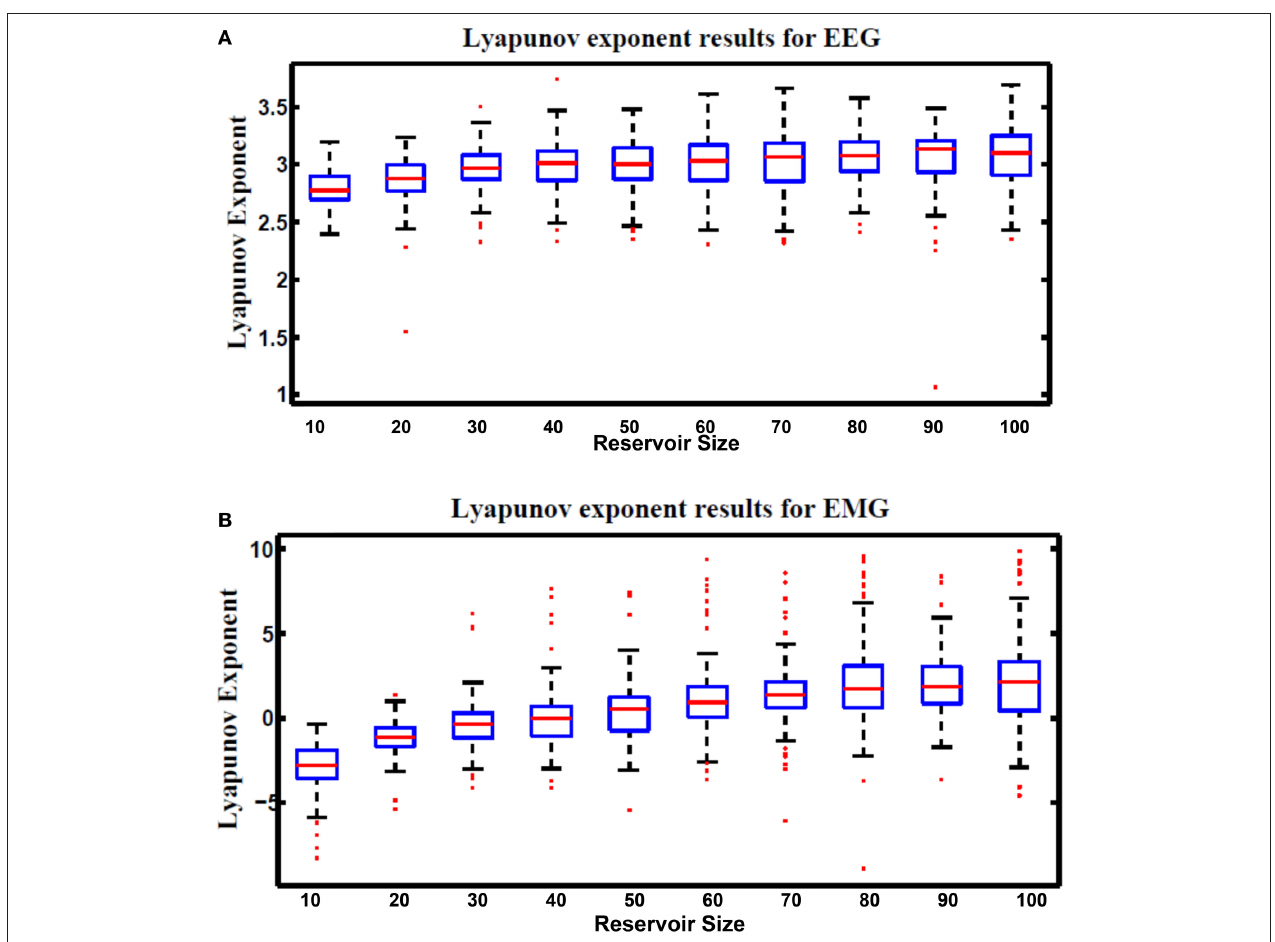
FIGURE 14 | Lyapunov’s exponent results vs. different reservoir sizes for hybrid topology reservoir testing (A) EEG and (B) EMG signals. The boxes represent the 25th and 75th percentiles of the measurements. The whiskers represent values outside the 25–75th percentiles.